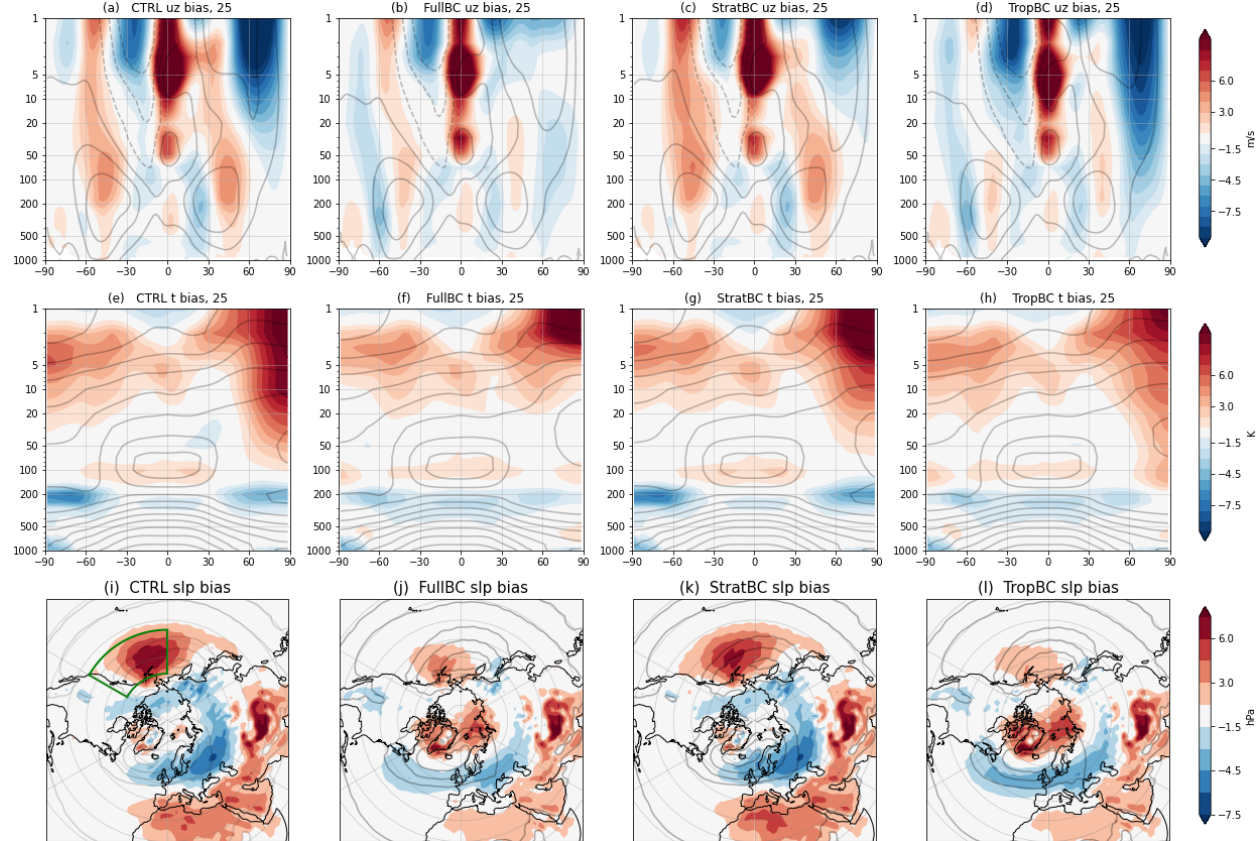
Figure 1. November–March bias of zonal mean zonal wind (top row), zonal mean temperature (middle row), and MSLP (bottom row) in the four experiments: CTRL (a, e, i) , FullBC (b, f, j) , StratBC (c, g, k) , and TropBC (d, h, l) . The bias is calculated as the difference between model and ERA-Interim climatology (1979–2009). Grey contours show model climatology. Negative winds in the top rows are marked with dashed lines. Contours are drawn at intervals of 10m/s for zonal winds ( − 30, − 20, ... , 30m/s), at 10K for temperatures (200, 210, ... , 290K), and at 5hPa for SLP (990, 995, ... , 1030hPa). The green box in (i) shows the area of the Aleutian low index used in Figs. 2, 4, and